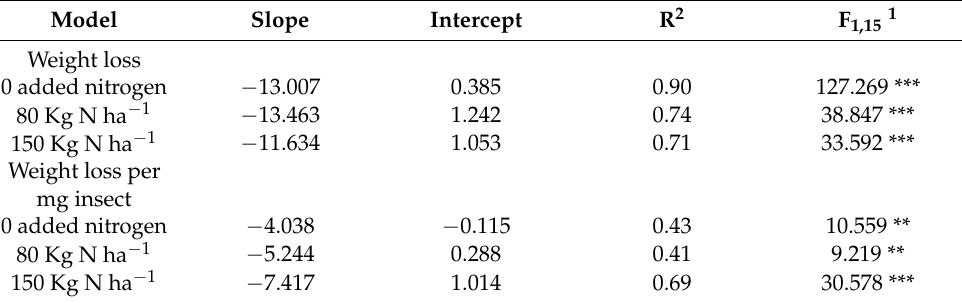
Figure 2. Relations between plant growth rate and ( A ) plant weight loss, and ( B ) weight loss per mg of planthopper for 16 rice varieties exposed to planthoppers under three nitrogenous fertilizer regimes (see legend). Each point is the average of three replicates. Best-fit linear models are indicated for each nitrogen level (Table 3). Table 3. Best-fit linear models for weight loss to plants under three different nitrogen regimes and plant weight loss per mg of planthopper (Figure 2).